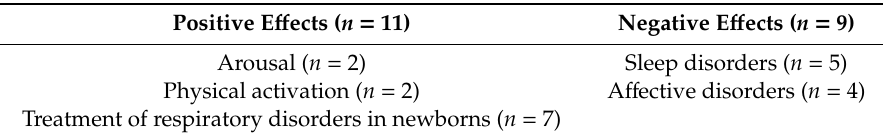
Table 2. Study categories of e ff ects produced by ca ff eine in children.